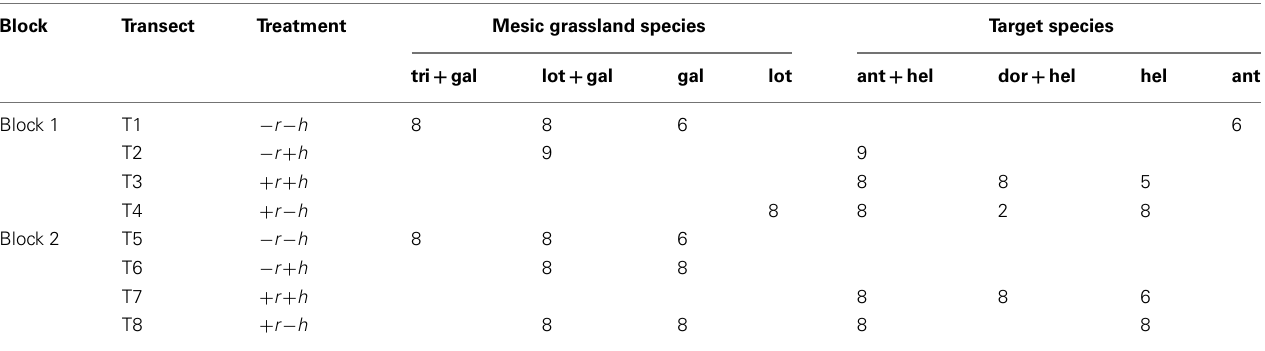
Table 2 | Overview of the number of plant pairs (non-legume species and their legume neighbor), control plants (non-legume species without legume neighbor) and legume species without non-legume neighbor sampled along transects in different restoration treatments, depending on availability of each species along